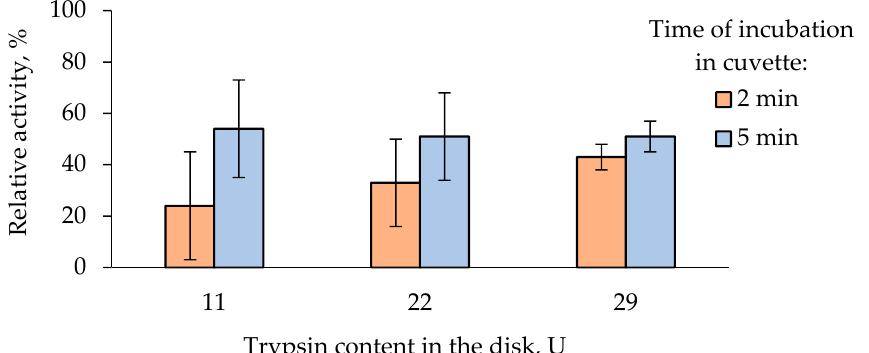
Figure 8. Relative activity of trypsin immobilized in starch gel in the presence of 5 g/L of glyphosate as the active ingredient of commercial pesticide Tornado Extra. Five g/L of glyphosate was determined as the IC 50 value for trypsin immobilized in starch gel; this value was obtained through pre-incubation of the immobilized enzyme in the pesticide solution for 5 min.